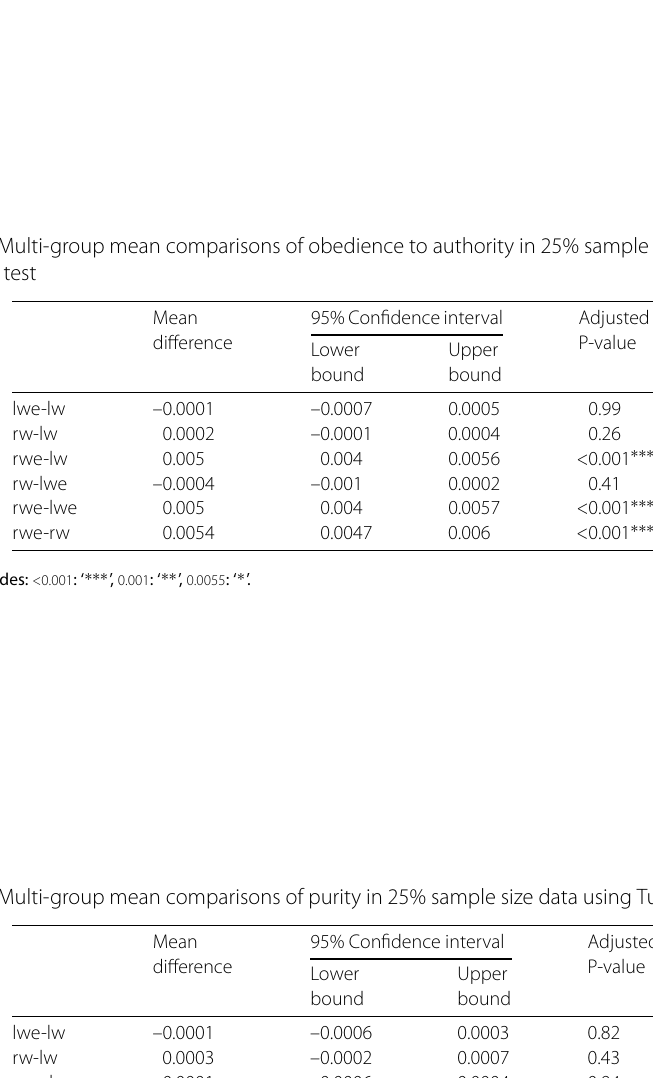
Table A11 Multi-group mean comparisons of purity in 25% sample size data using Tukey’s HSD test Mean 95% Confidence interval Adjusted difference P-value Lower Upper bound bound lwe-lw –0.0001